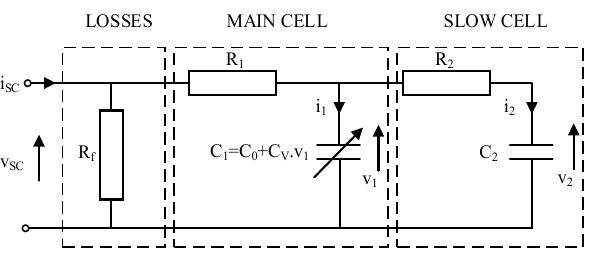
Figure 9. A simplified model of the supercapacitor.